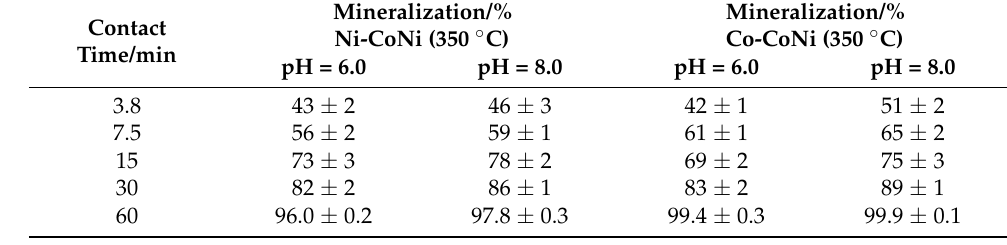
Table 5. Mineralization of TCs as a function of the duration of contact with the catalysts.